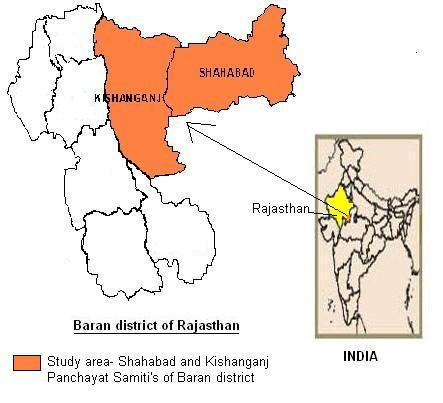
Map of study area.